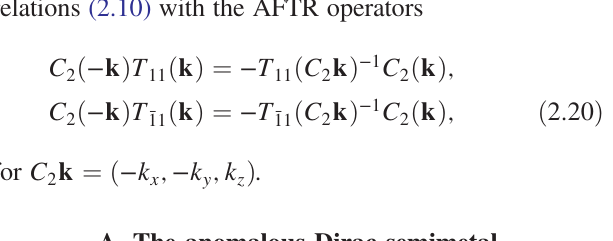
FIG. 7. Energy spectrum of the coupled Dirac wire model